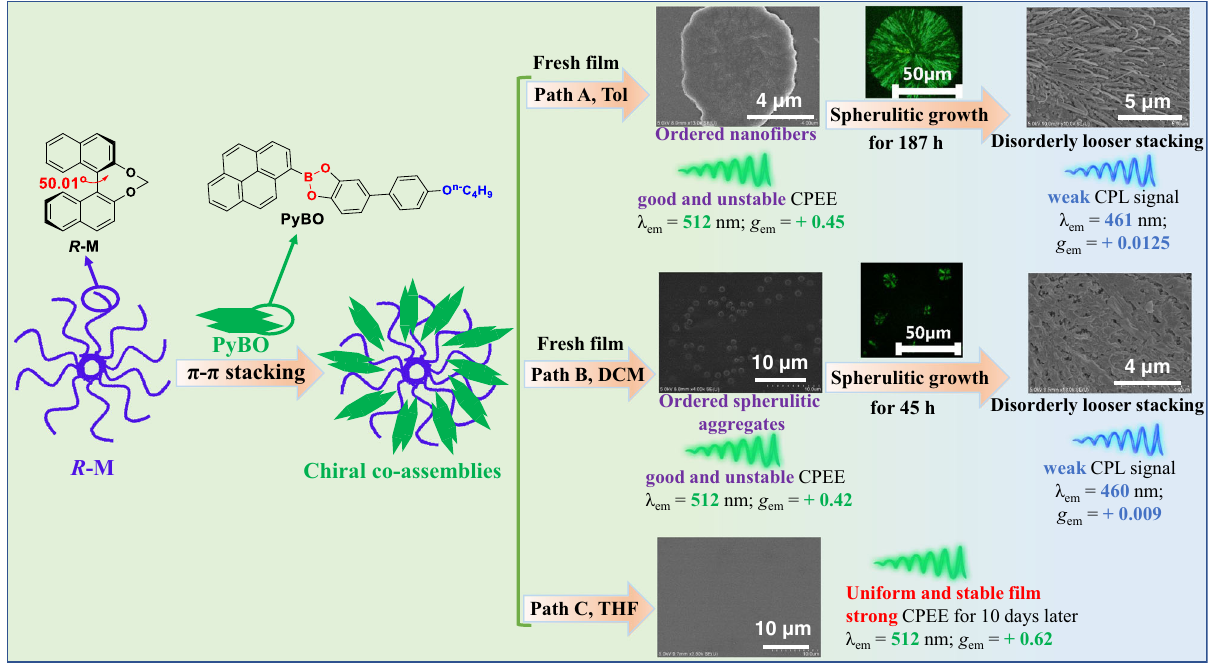
Fig. 1 | Schematic representation. Schematic representation of dynamic CPEE based on the chiral co-assembly process.